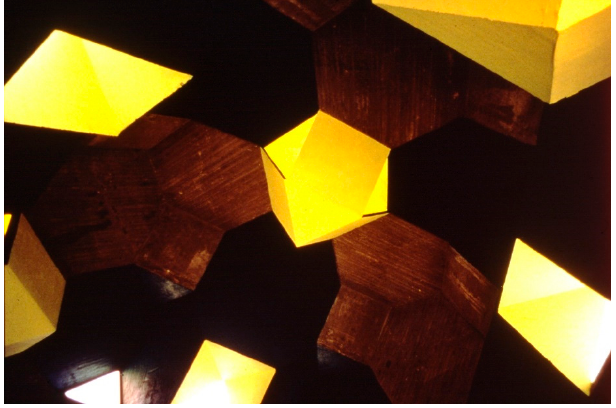
Figure 14. The Military Officers’ Academy Synagogue in Mitzpe Ramon, interior, detail. Photo: Zvi Hecker, 1969–1970. Courtesy of Zvi Hecker, architect.